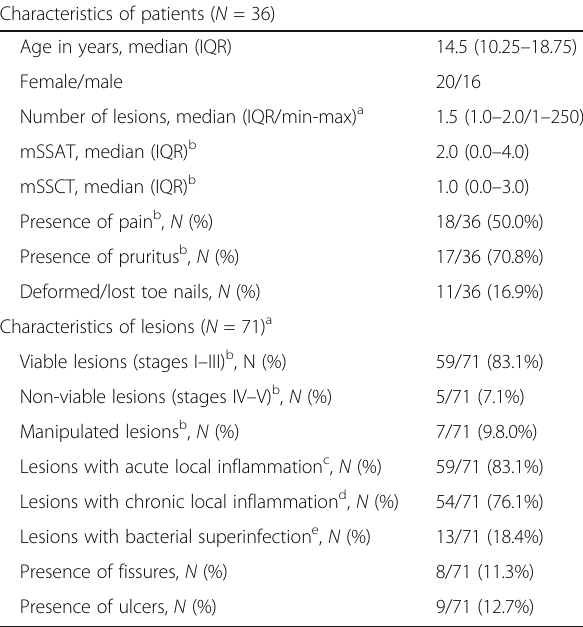
Table 2 Demographic, clinical and parasitological